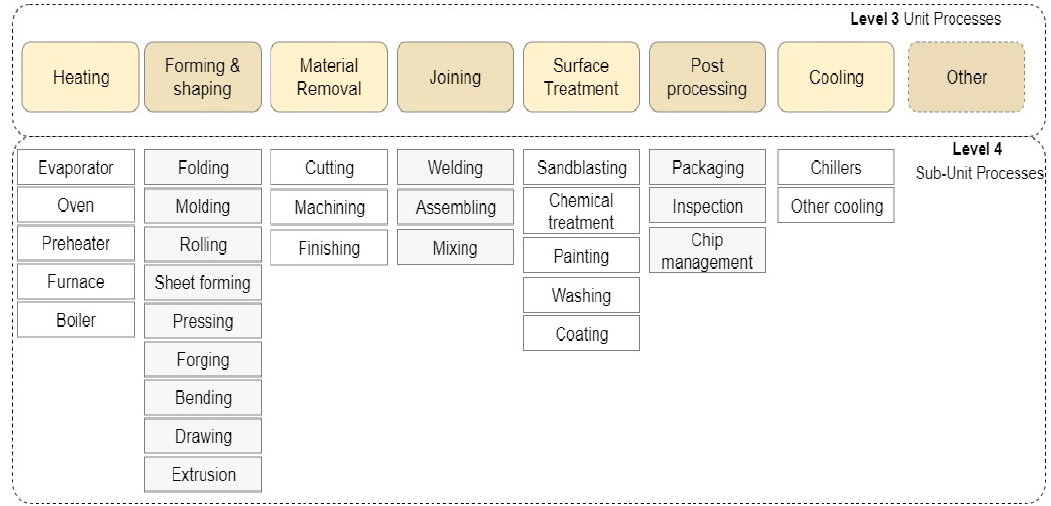
Figure 5. Tree showing Level 1, Level 2, and Level 3 categories of EEU taxonomy in the engineering industry.